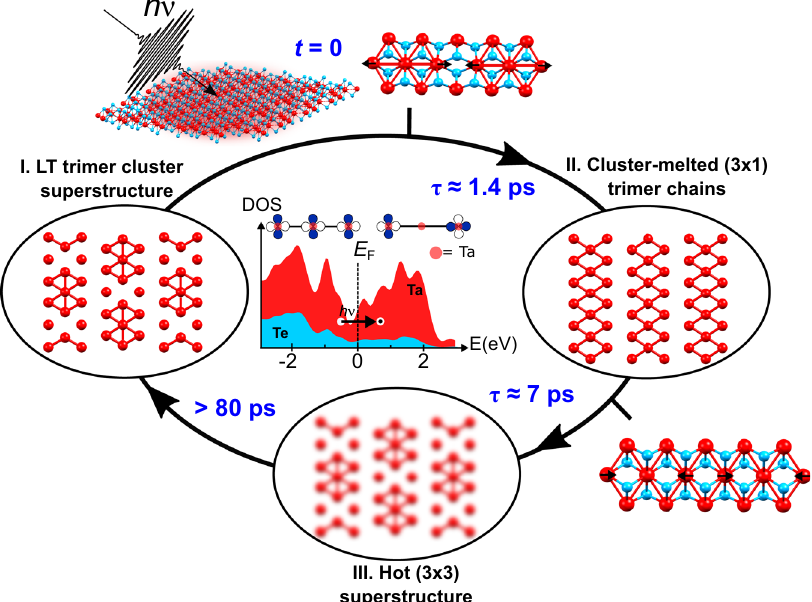
Fig. 4 Proposed stages of the photo-induced dynamics in 1T ′ -TaTe 2 . The system starts in the low-temperature (LT) phase with a (3 × 3) superstructure of Ta trimer clusters ( I ). Near-infrared excitation promotes carriers from bonding to non-bonding states via a charge-transfer excitation, which results in melting of the trimer clusters and leaves behind stripe-like trimer chains ( II ). Subsequently, the lattice subsystem thermalises, causing the (3 × 3) superstructure to re-establish and stablise at elevated temperatures ( III ). Inset: density of states (DOS) projected onto Ta and Te atoms as calculated using density functional theory, along with schematic optically induced promotion from bonding to non-bonding Ta orbitals, which lie in the plane. E F denotes the Fermi level. The participating Ta trimer bonding and non-bonding (with a node in the middle) orbitals are